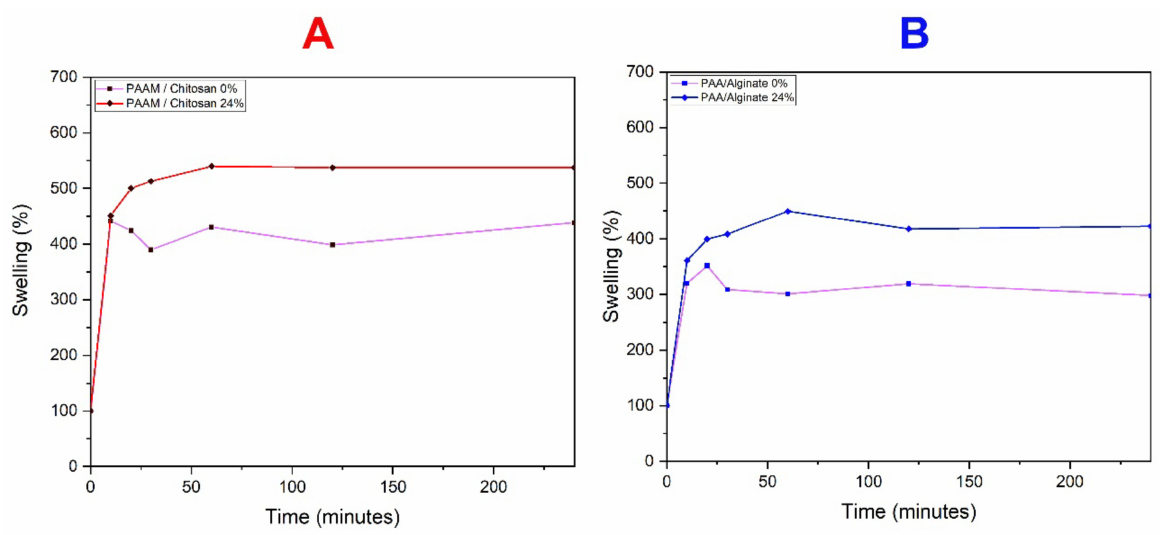
Figure 3. Swelling of ( A ) PAAM/chitosan and ( B ) PAA/alginate xerogels in